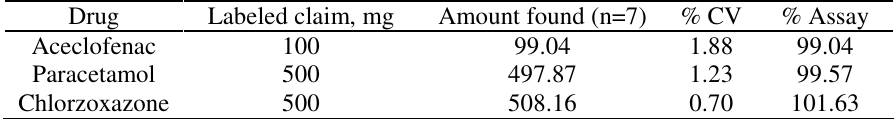
Table 1. Results of assay